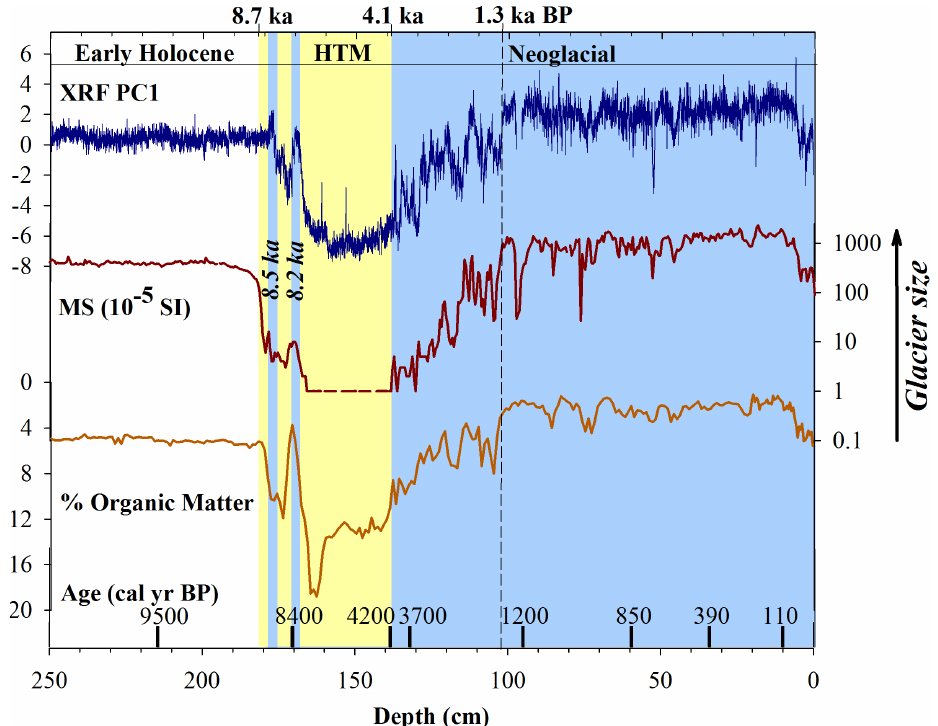
Figure 3. Kulusuk Lake record. (Top) First principal component of the scanning XRF data (PC1). (Middle) Magnetic susceptibility presented on a log scale. A dotted line defines the interval from 165–140cm where some zero values were measured. (Bottom) Organic-matter content. Black bars indicate the location and age of chronologic control points (Table 1). The yellow shaded region on the PC1 plot shows where we have interpreted little to no glacier ice in the catchment during the Holocene Thermal Maximum (HTM). Blue shading defines the Neoglacial period when ice was reformed during the late Holocene